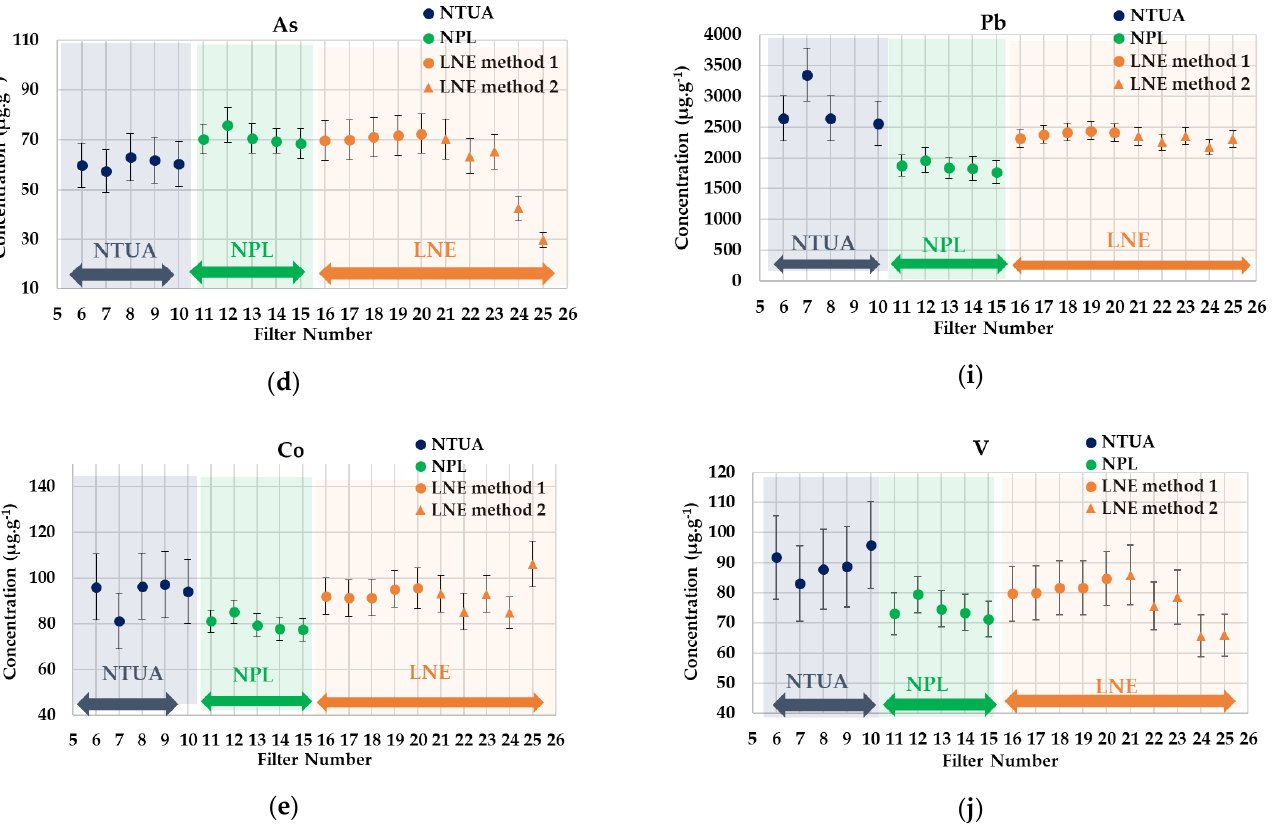
Figure 4. ICP-MS intercomparison results for PM 2.5 -loaded filters. ( a ) Cr, ( b ) Fe, ( c ) Cu, ( d ) As, ( e ) Co, ( f ) Mn, ( g ) Ni, ( h ) Zn, ( i ) Pb and ( j ) V.